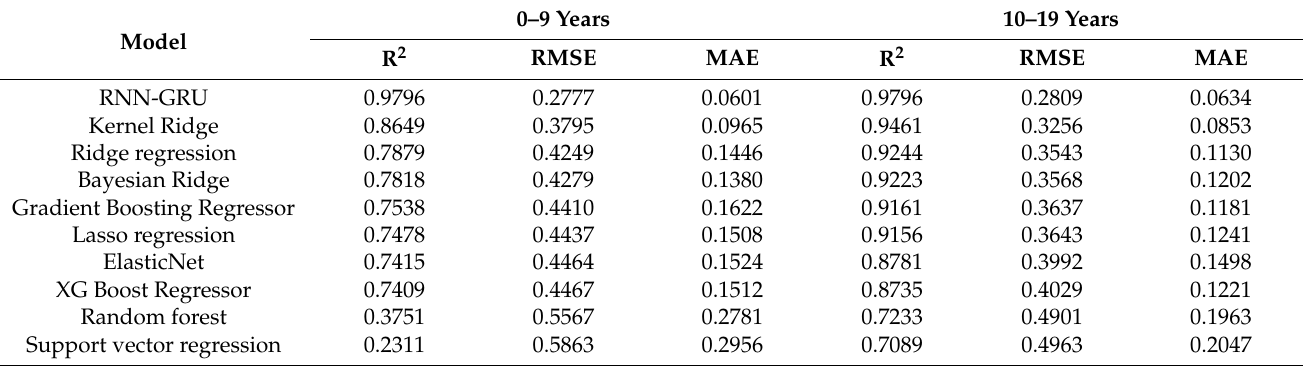
Table 3. Results of model evaluation for groups 0–9 and 10–19.